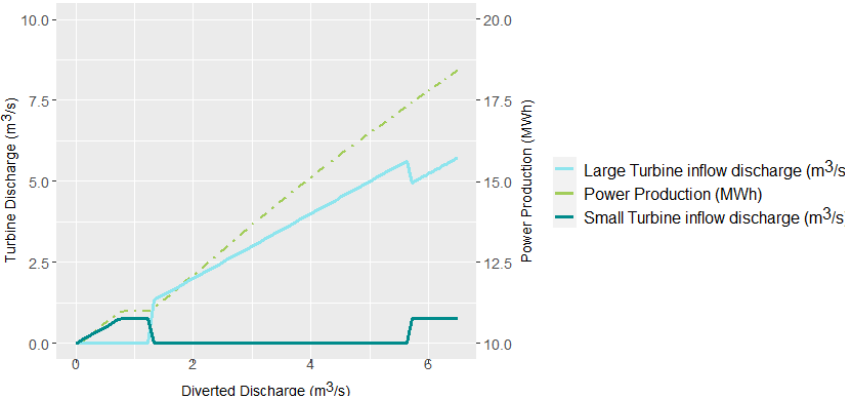
Figure 3. Optimal sharing of discharge conveyed to the two turbines and associated power